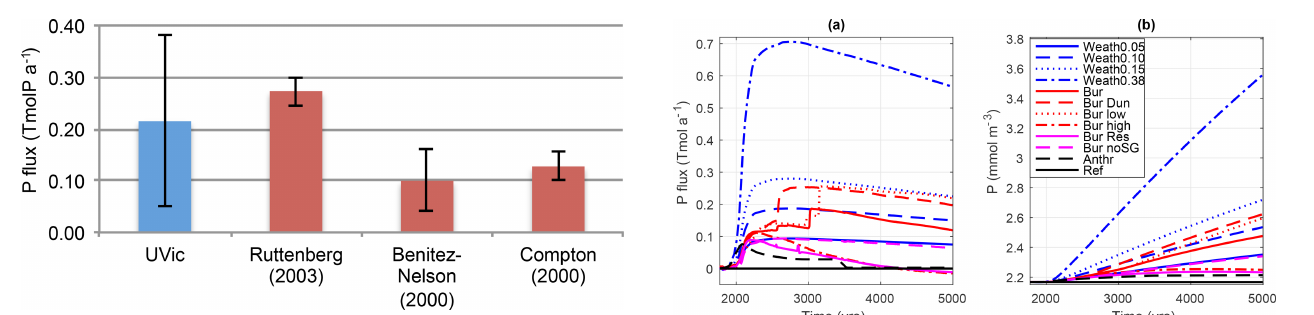
Figure 2. (a) Globally integrated flux of P in Tmola − 1 to the ocean and (b) globally averaged phosphate concentration in mmolm − 3 . Simulation descriptions can be found in Table